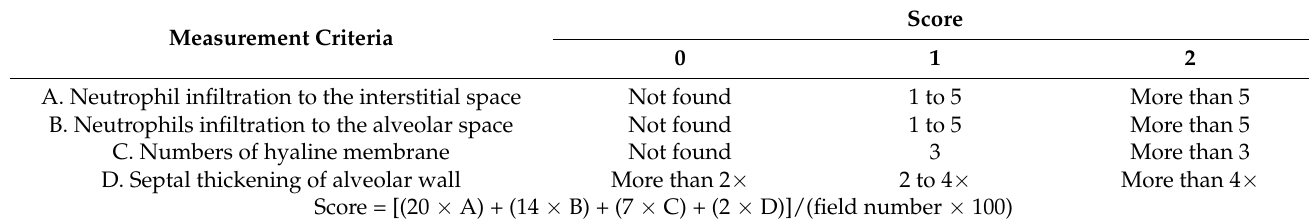
Table 2. Scoring lung injury with methods from American Thoracic Society